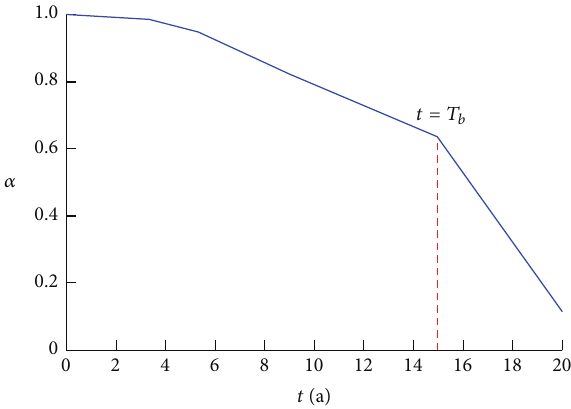
Figure 9: Effect of corrosion on reduction in pile foundation stability.